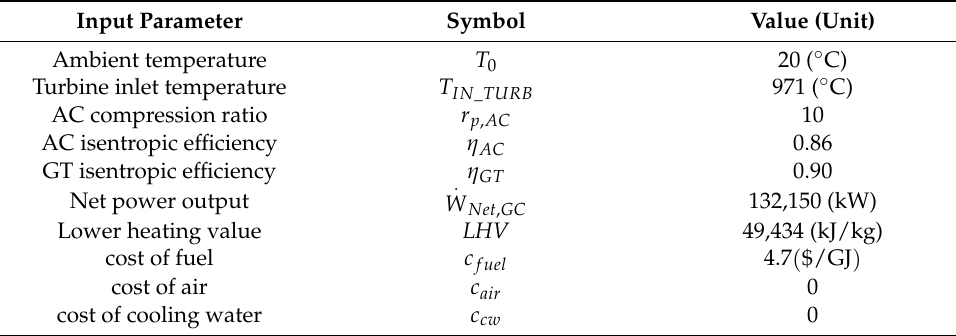
Table 1. Technical input data of the gas turbine cycle [18].